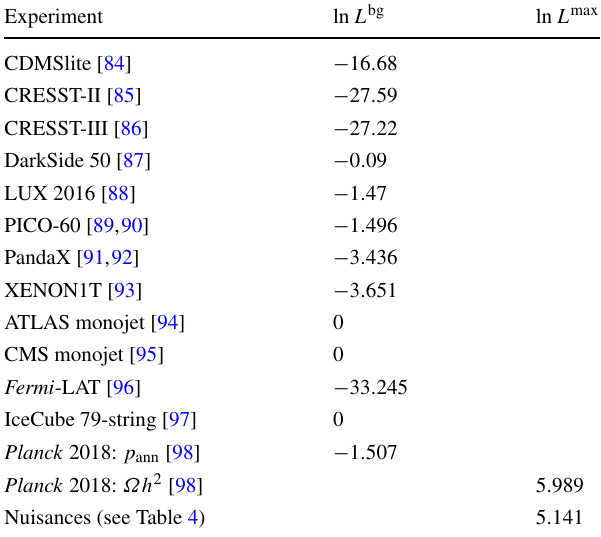
Table 1 Likelihoods included in our scans and their respective values for the background-only hypothesis. For each likelihood that directly constrains the interactions of the DM particle we also quote the background-only log-likelihood ln L bg obtained when setting all Wil- son coefficients to zero. For the remaining likelihoods we instead quote the maximum achievable value of the log-likelihood ln L max